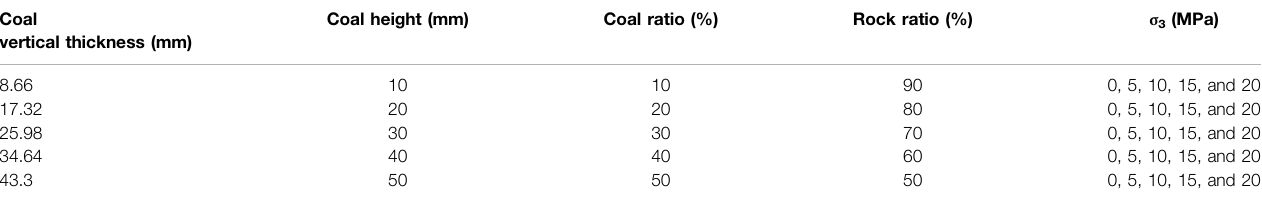
TABLE 1 | The detailed dimensions of the inclined RCR composite samples at different con fi ning pressures.